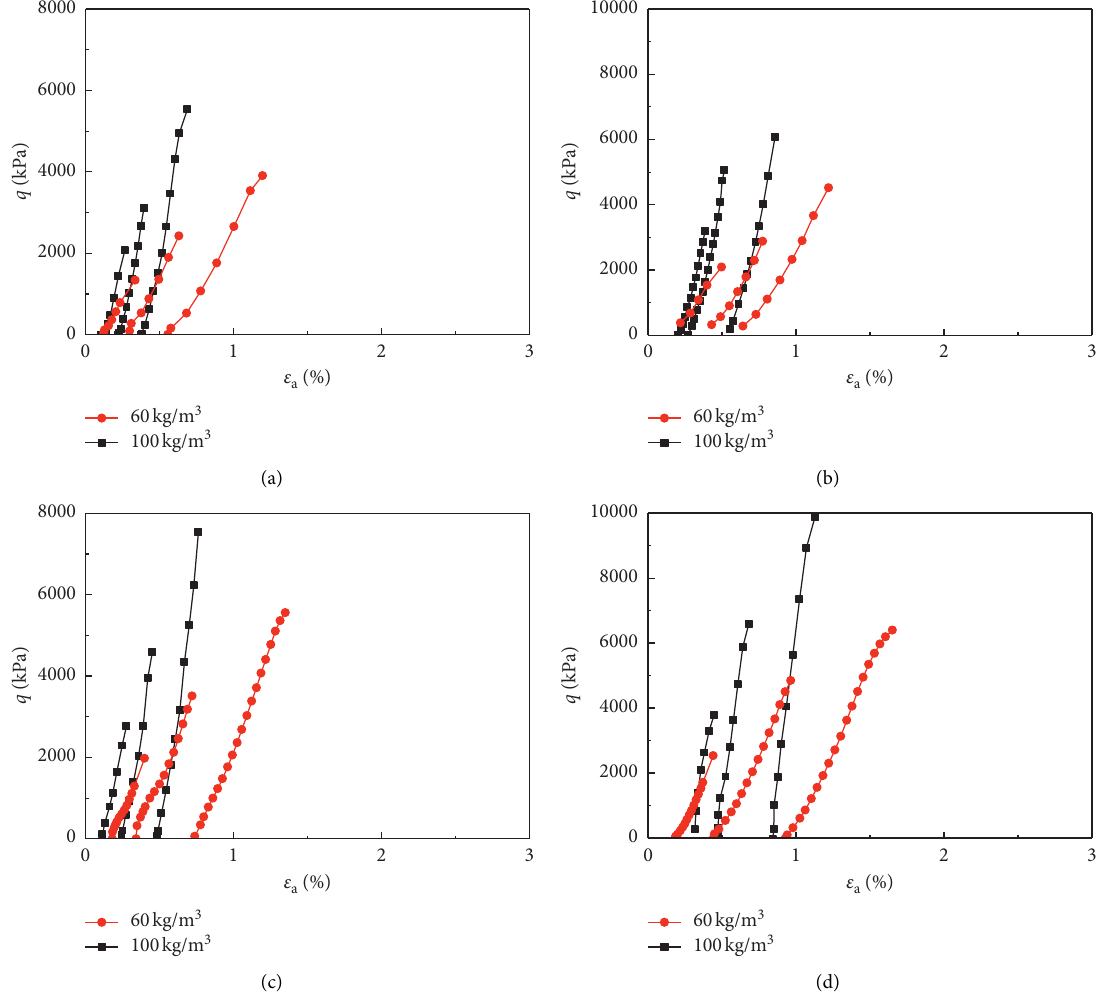
Figure 8: LCSG material reloading curves for different confining pressures. (a) 300kPa. (b) 600kPa. (c) 900kPa. (d)